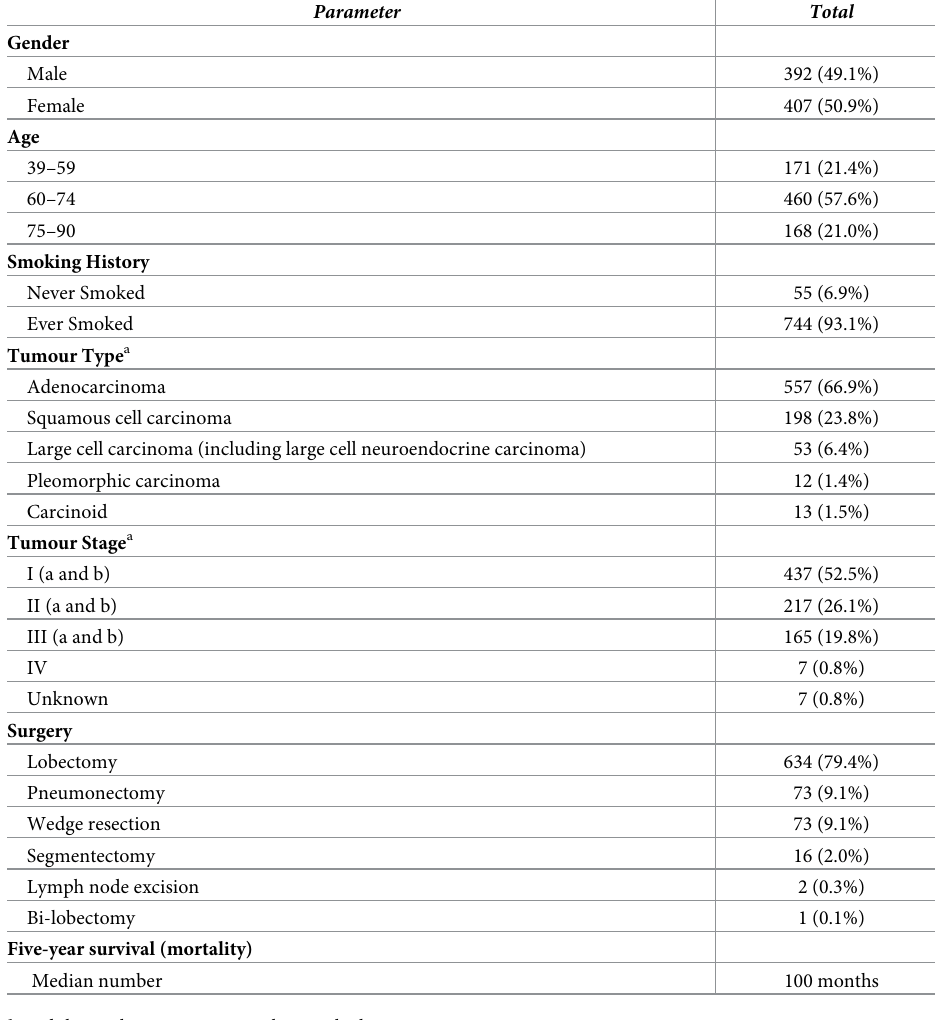
Table 1. Demographic data of the 833 samples from the 799